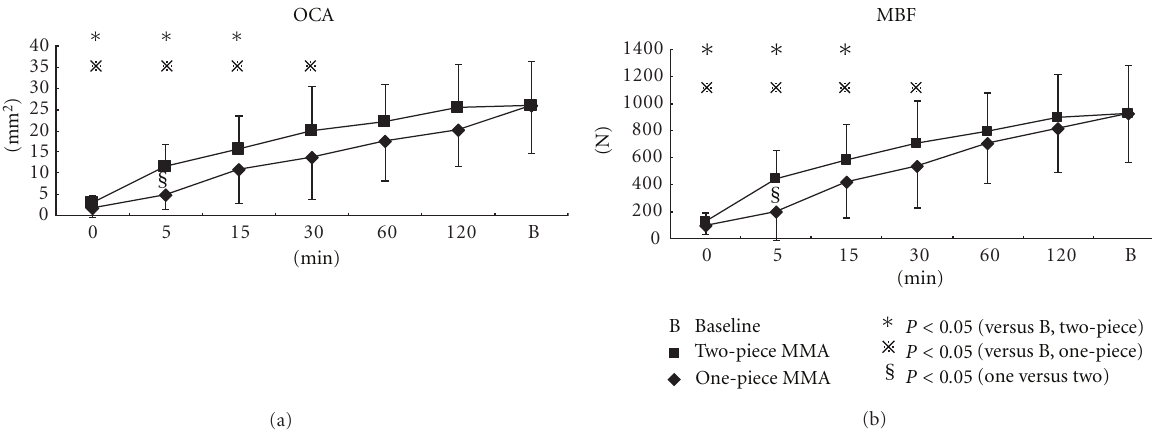
Figure 8: (a) Changes in occlusal contact area after nocturnal use of di ff erent MAAs, (b) changes in maximum bite force after nocturnal use of di ff erent MAAs.